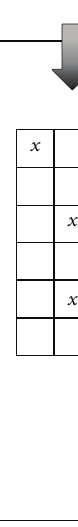
Figure 6: Optimal small-scale wind field configuration.